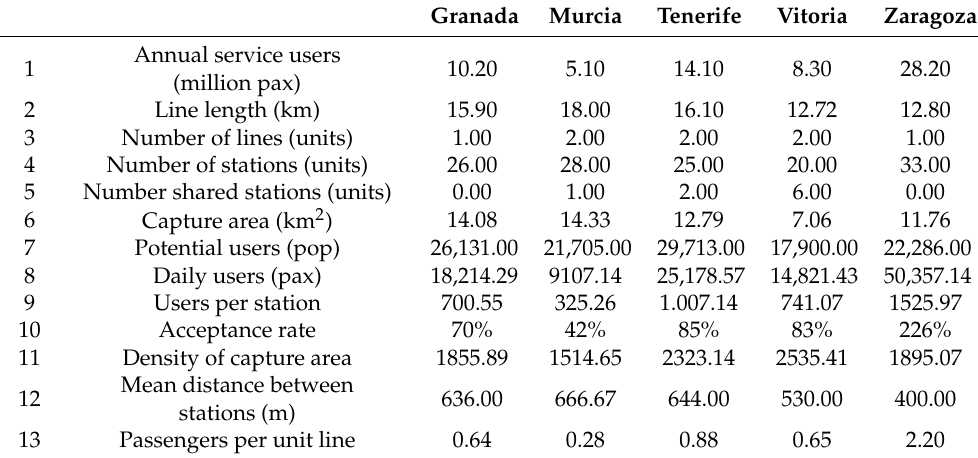
Table 3. Group 1 results.